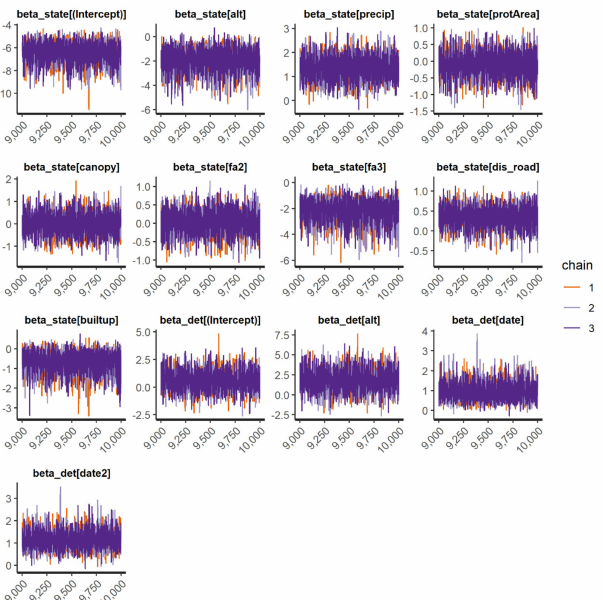
Figure A12. Traceplots from the best occupancy model of American bullfrog ( Lithobates catesbeianus ) in Puerto Rico: ( ψ (intercept + elevation + precipitation + protected area + canopy cover + fa2 + fa3 + distance of road + built up); ρ (intercept + elevation + date + date2)). Note: alt = elevation; precip = mean annual precipitation; protArea = proportion of protected area; canopy = proportion of canopy cover; fa2 = proportion of forest cover aged between 32 and 54 years; fa3 = proportion of forest cover aged 55 years and older; dis_road = minimum distance from road; builtup = built-up proportion; date = Julian date (we considered Julian day 1 as the first day of a device starting to record in the field, which was 1 March 2021); date2 = square of Julian